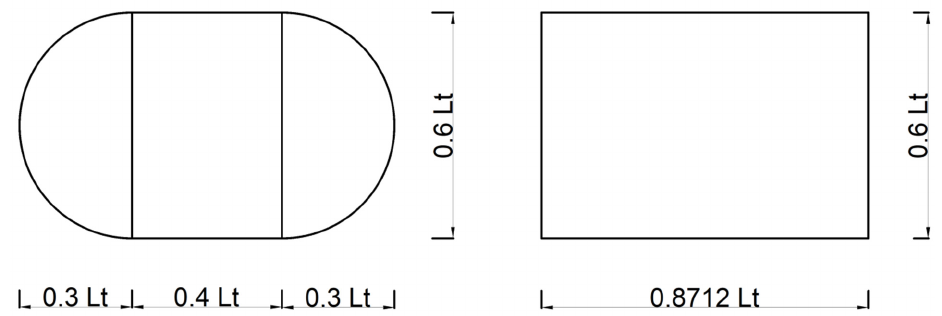
Figure 2. The conversion method of wheel equivalent area.